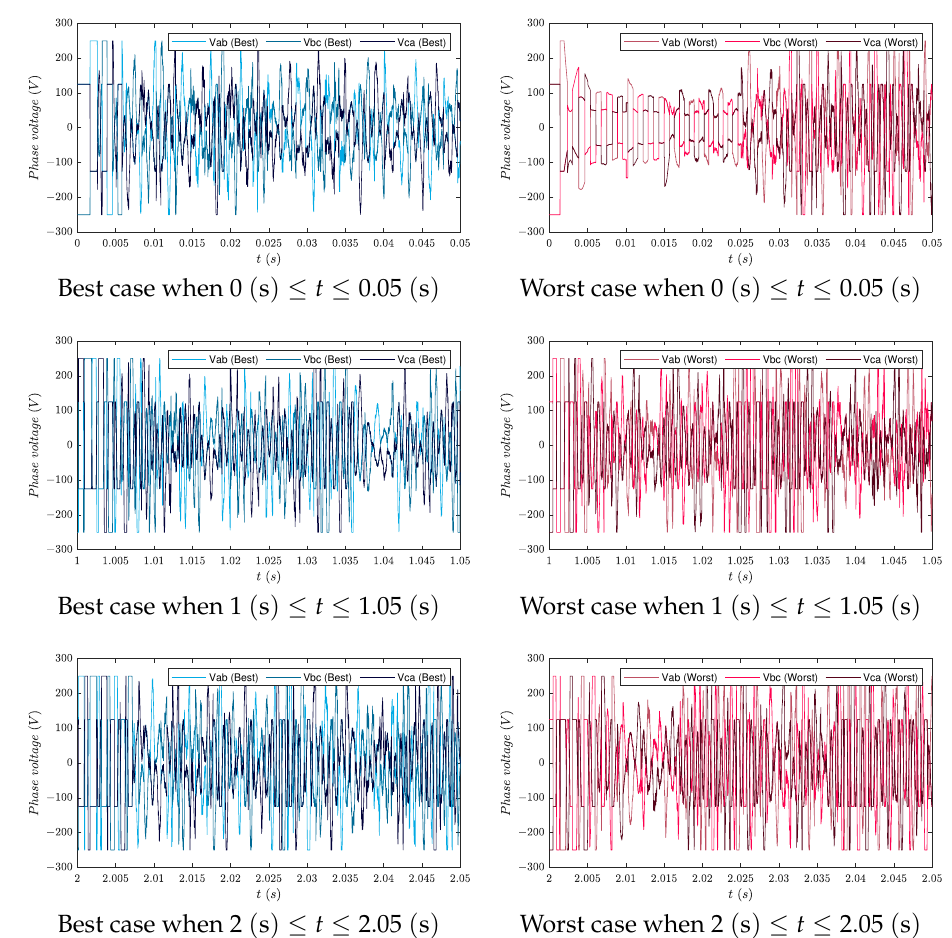
Figure 11. Phase voltages in the motor obtained with the best and worst runs of CATSCG, consider- ing